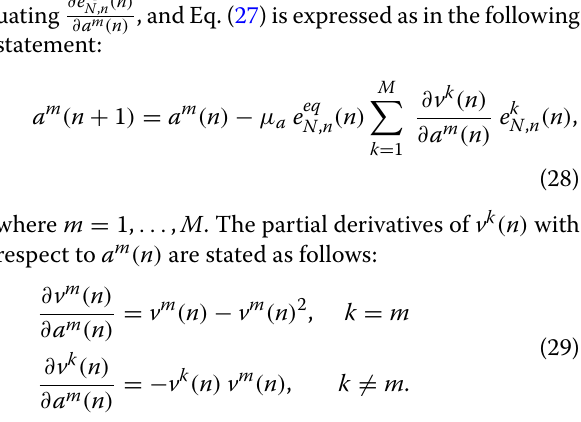
The m th mixing coefficient at time instant n + 1 is com- puted at the output of the last lattice stage in a type-2 combination processor as